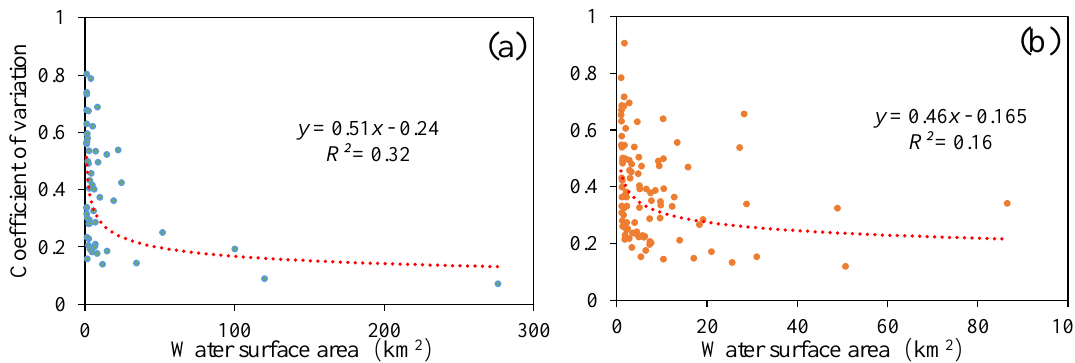
Figure 13. Coe ffi cient of variation in the relationship with ( a ) water surface area of ponds and lakes and ( b ) reservoirs. Reservoirs were identified in the Google Earth map. The power function shows the relationship between CV and water surface area in the types of water bodies. the Y -axis indicates that the CV shrank 100 times.